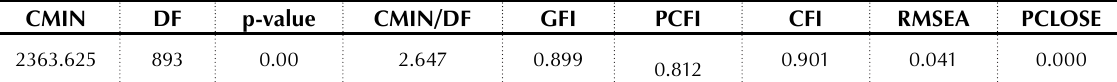
Table 3. Index of the model fit